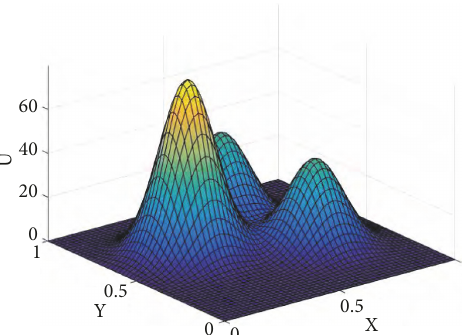
Figure 13: A synthetic surface generated by superposition of three different Gaussians, that is to be approximated by local s-PGD techniques.